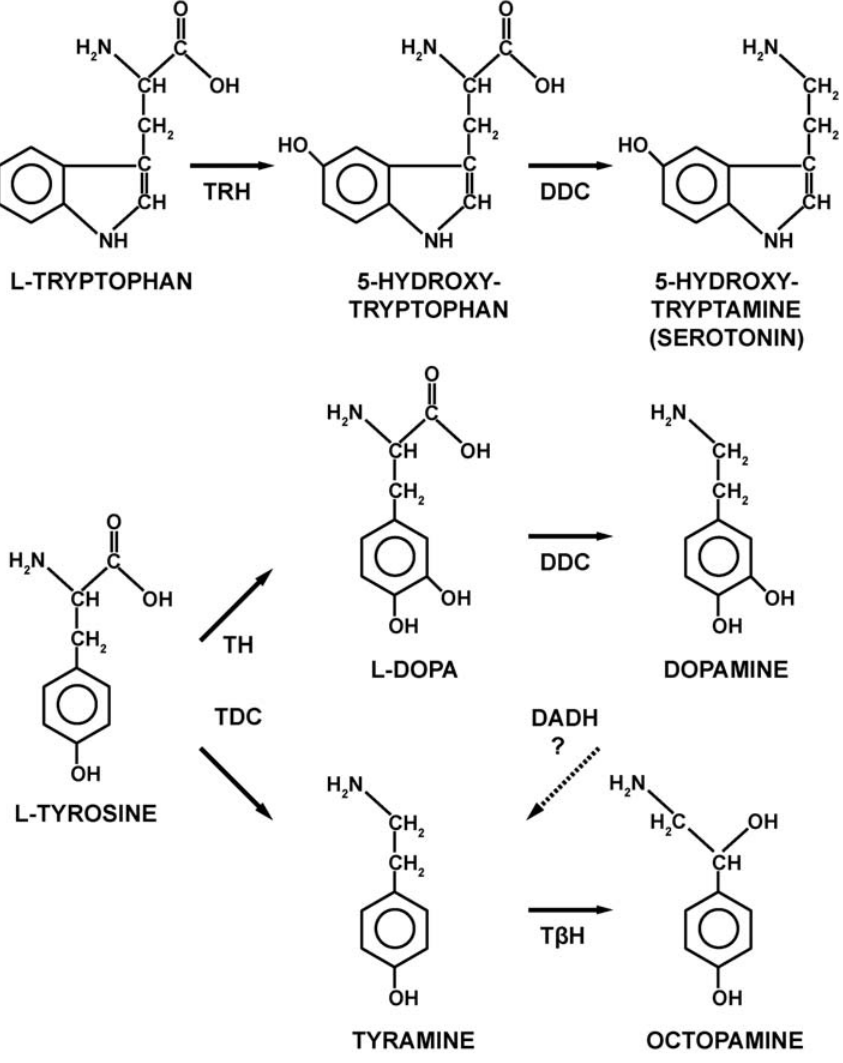
Figure 1. Synthetic pathways for serotonin, dopamine, tyramine, and octopamine. The amino acid tryptophan is the starting point for the synthesis of 5-hydroxytryptamine (5-HT, serotonin), whereas tyrosine is the source for dopamine as well as tyramine and octopamine. An alternative pathway (dotted arrow) via DADH may exist that permits the synthesis of tyramine from dopamine. DADH: dopamine dehydroxylase; DDC: DOPA decarboxylase; T b H: tyramine b -hydroxylase; TDC: tyrosine decarboxylase; TH: tyrosine hydroxylase; TRH: tryptophan hydroxylase. doi:10.1371/journal.pone.0001848.g001 PLoS ONE |